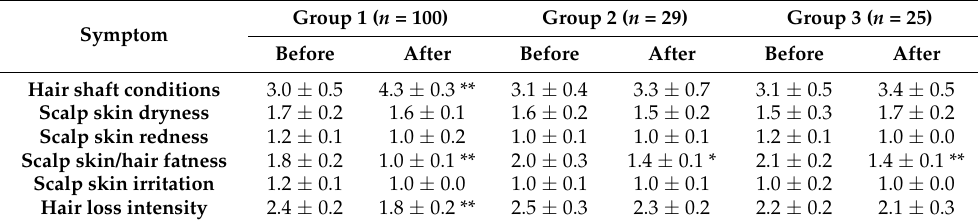
Table 1. Dynamics of subjective professional clinical assessment (score) by a dermatolo- gist/trichologist for the hair conditions in the three groups of participants ( n = 154) before and after the trial. Symptom Before After Before After Before After Hair shaft conditions